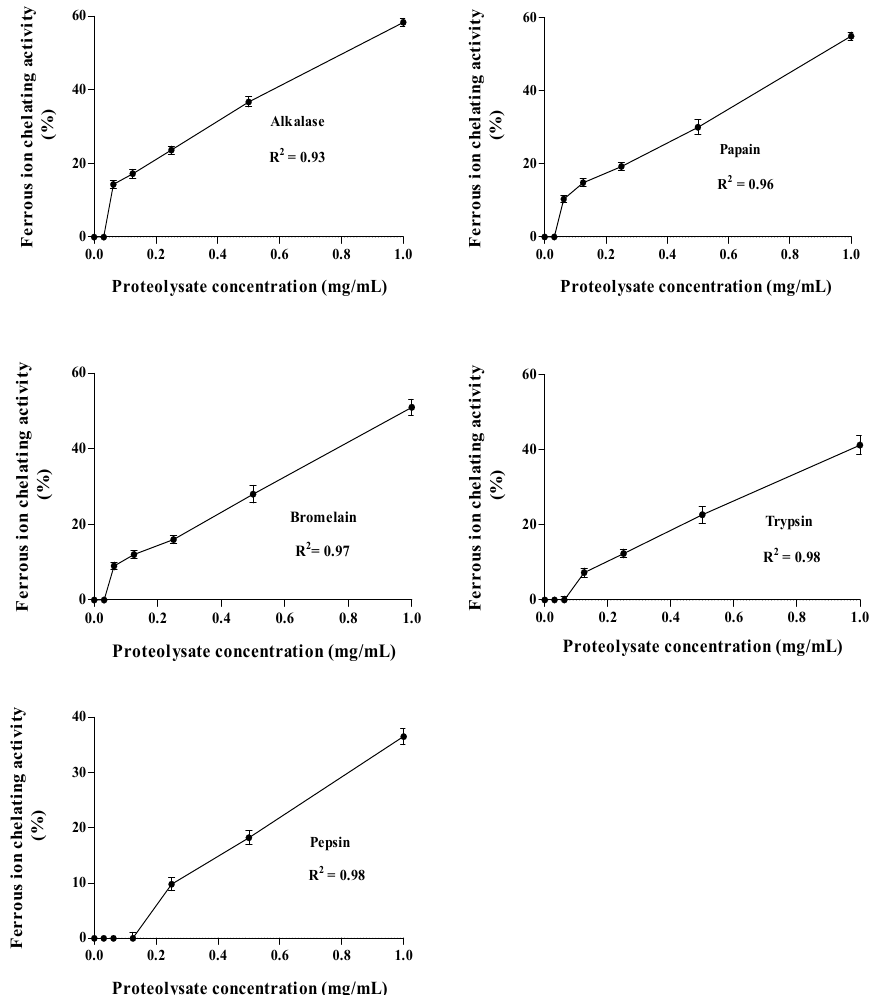
Figure 6. Changes in ferrous ion chelating activities (%) of A lecanora /hydrolysates at concentration between 0.0 and 1.0 mg dry weight/mL Each value is the mean ± SD of three replications.